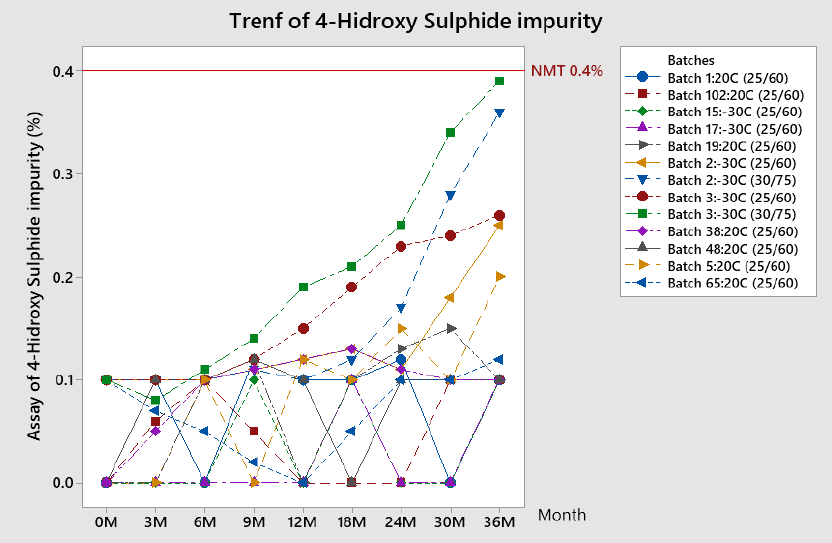
Figure 10. Trend of 4-hydroxy-sulfide for stability batches. The assay of 4-hydroxy sulfide impurity for most of the examined batches stays at the same level during shelf life—around 0.1%. The increase of 4-hidroxy sulfide assay can be noticed in both conditions for batches 2 and 3, which are stored at −30 °C before lyophilization. All results are within specifications (limit 0.4%). Trend of 5-Methoxy-1H-benzimidazole-2-sulfinic Acid The trend of results for 5-Methoxy-1H-benzimidazole-2-sulfinic acid obtained during stability, for all batches produced (stored at both temperatures of 20 °C and −30 °C before lyophilization), is given in Figure 11. Figure 11. Trend of 5-Methoxy-1H-benzimidazole-2-sulfinic acid during stability study (conditions 25 °C/60% RH). Results for most of the batches kept at 20 °C and −30 °C before lyophilization started are within specifications except for batch number 5 (kept at 20 °C), batch number 2, and